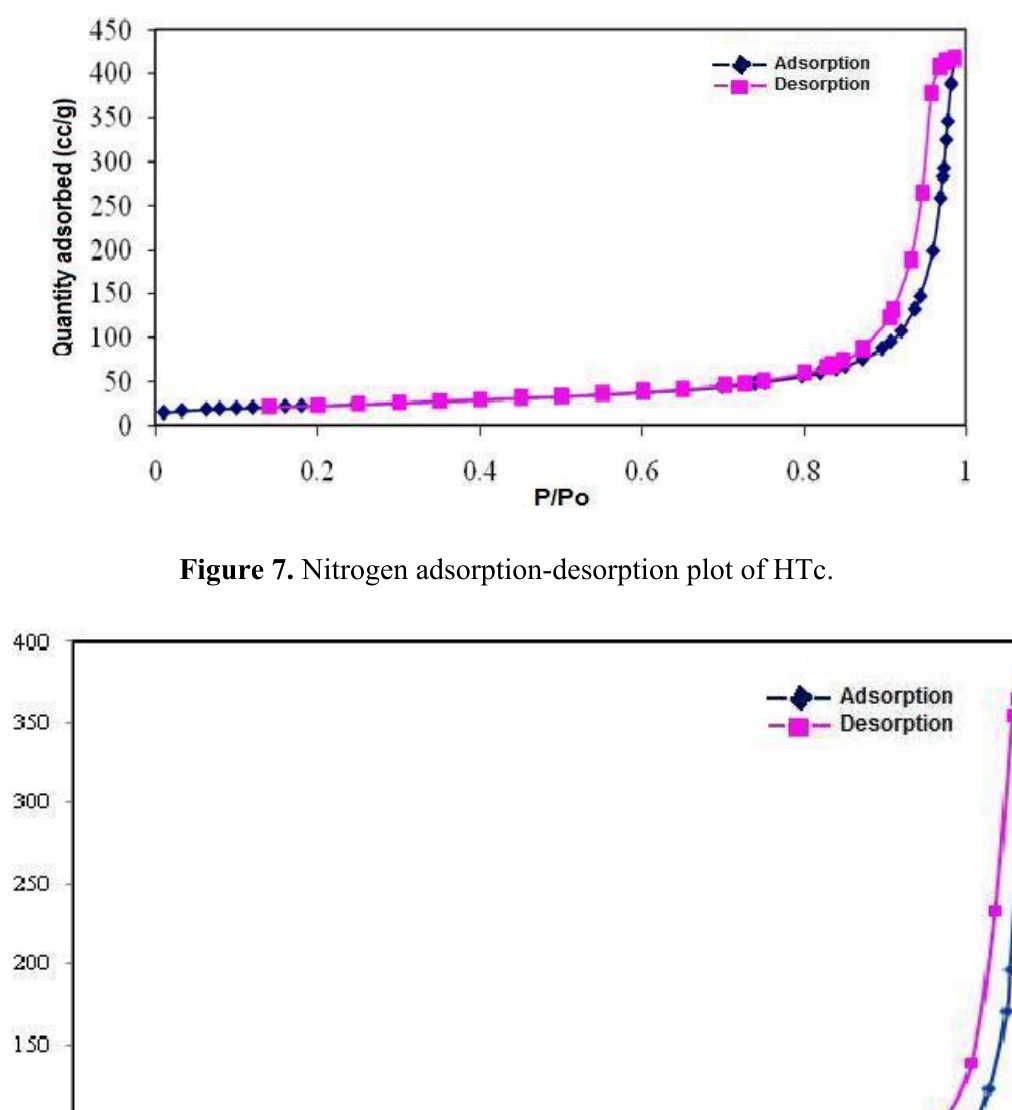
Figure 6. Nitrogen adsorption-desorption plot of HTs.